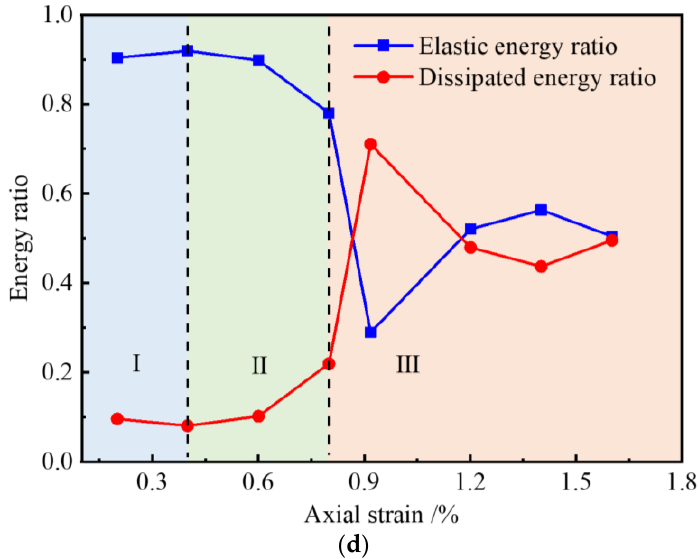
Figure 10. The evolution of the energy ratio with axial strain under different gas pressures (I, the compaction and linear elastic stage; II, the yield stage; III, the post-peak stage). ( a ) Gas pressure 0 MPa, ( b ) gas pressure 1 MPa, ( c ) gas pressure 2 MPa, and ( d ) gas pressure 3